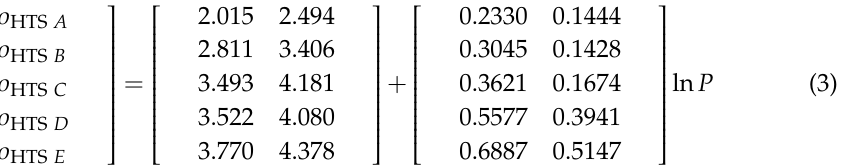
Figure 5. Bulk densities’ increasing tendency of porous PTFE/Al/W reactive materials.